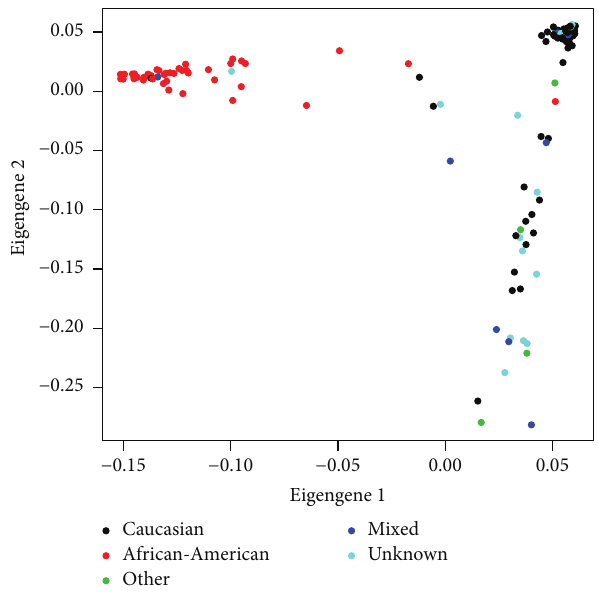
Figure 1: Population stratification via null